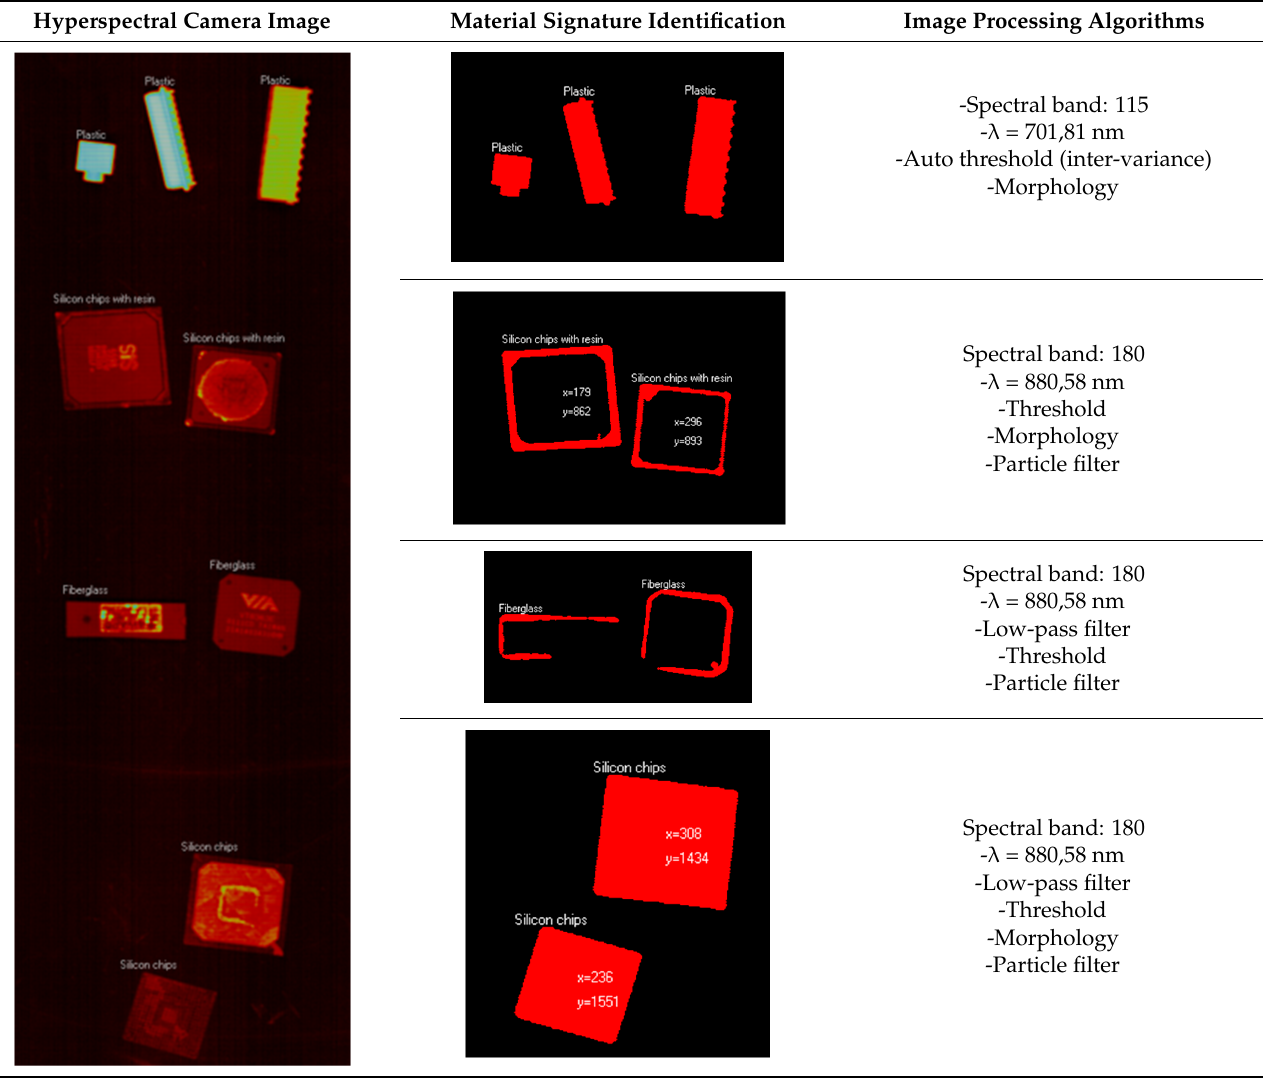
Table 1. Hyperspectral image detection and processing.